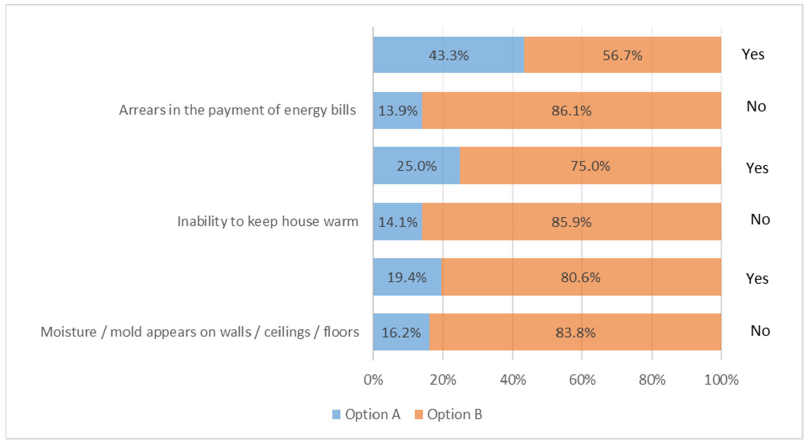
Figure 12. Present bias investigation by energy ‐ vulnerable and non ‐ vulnerable households—subjective indicators.